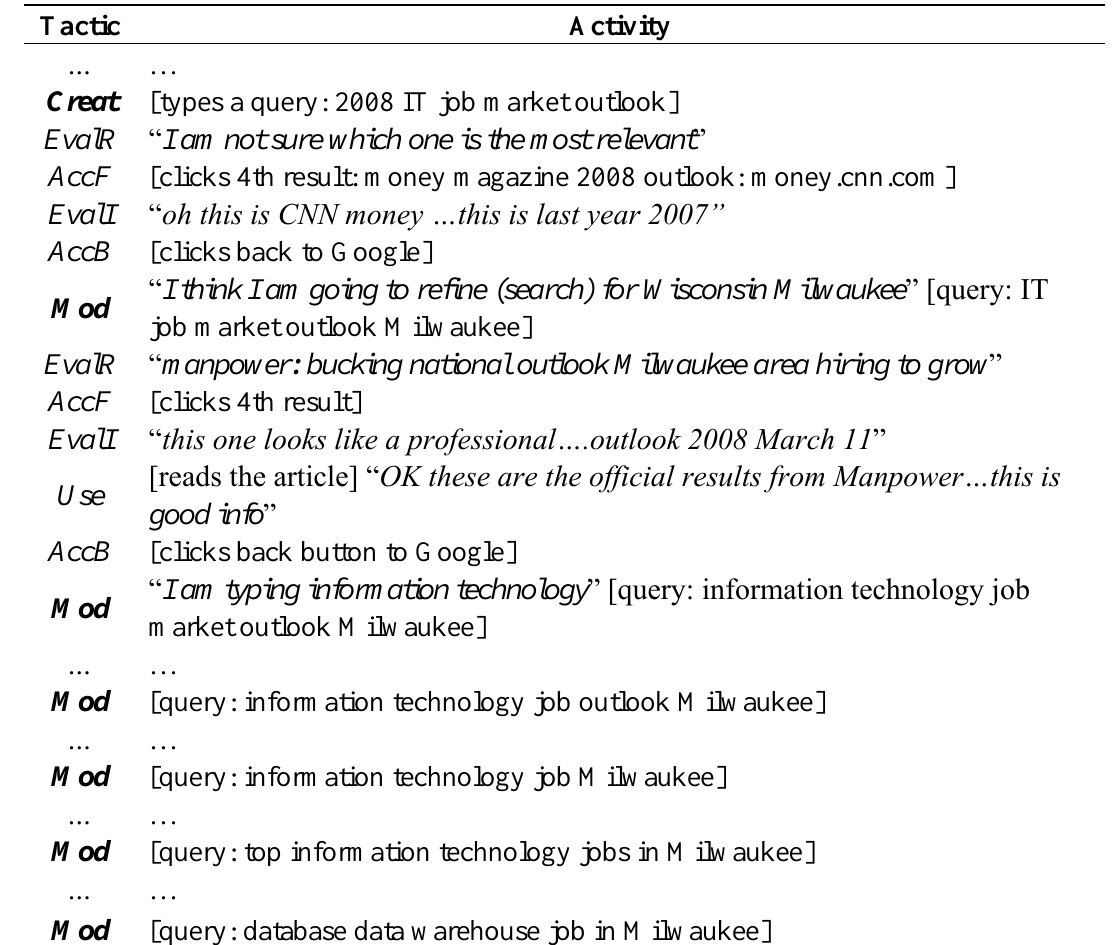
Table 8. Multiple query reformulation